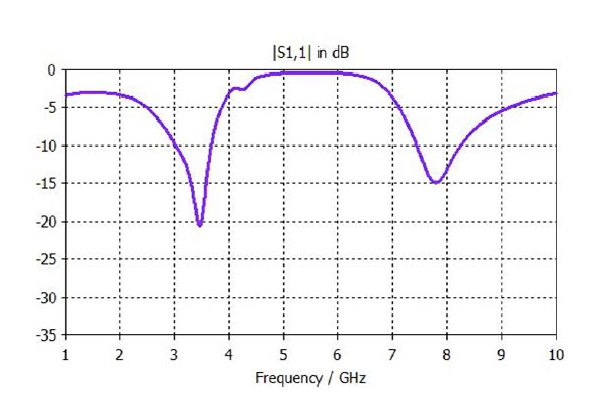
Figure 3 : Dual band response of the proposed quasi-fractal antenna.